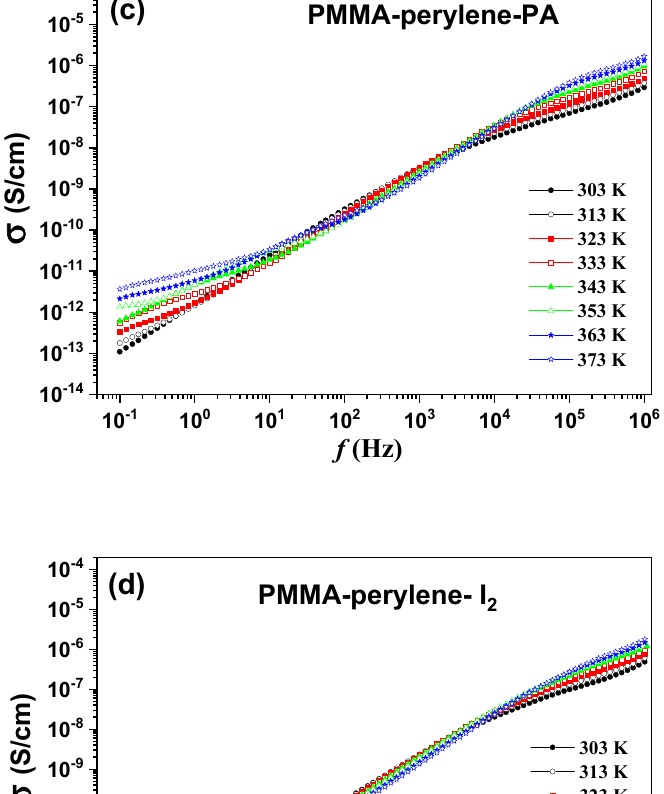
σ ( ω ) of the synthesized polymeric